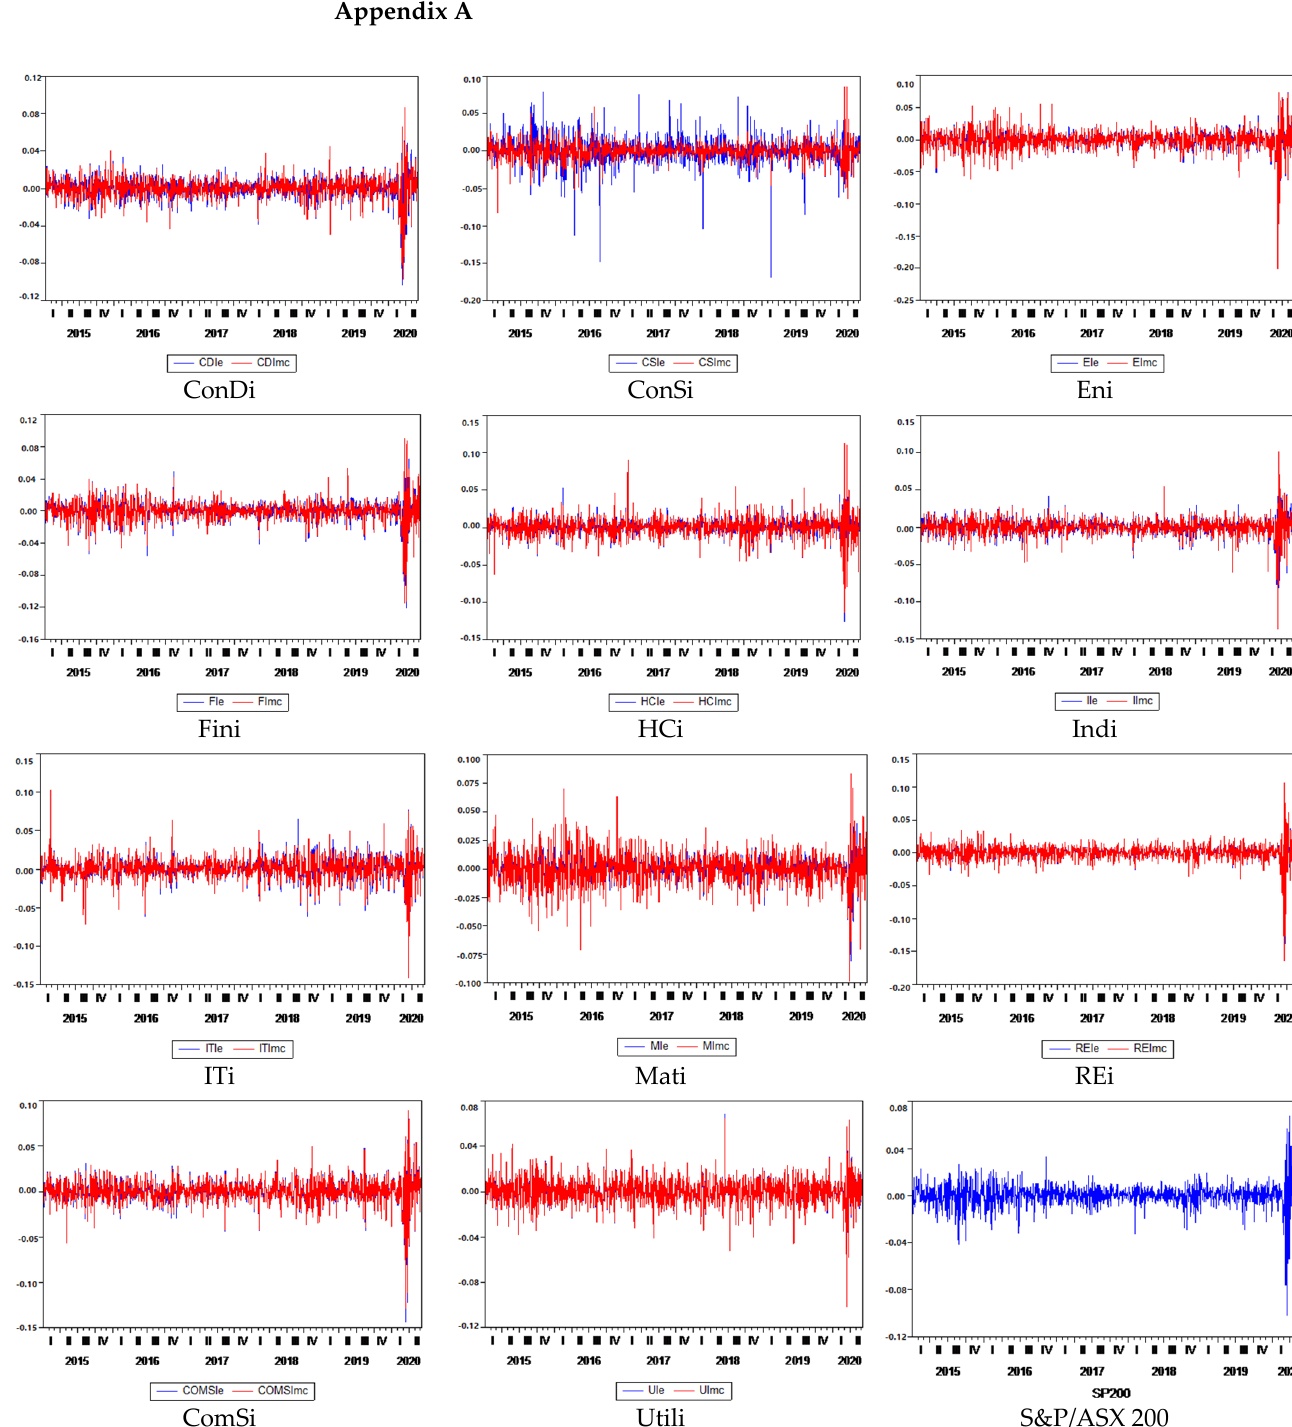
Figure A1. Returns of the Variables. Note: For all graphs, the x -axis shows time and the y -axis shows return for each index. Equally weighted sector indices are shown in blue and market capitalization sector indices are shown in red.